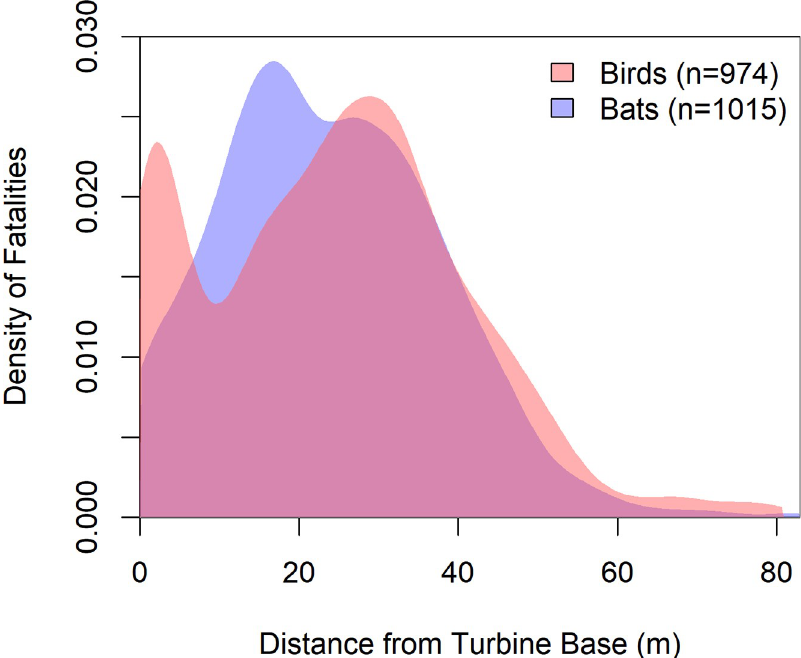
Fig 3. Density distributions for the fall distance of birds and bats at wind turbines in the Northeastern US. For density distributions of the 10 most frequent families, see S11–S20 Figs.